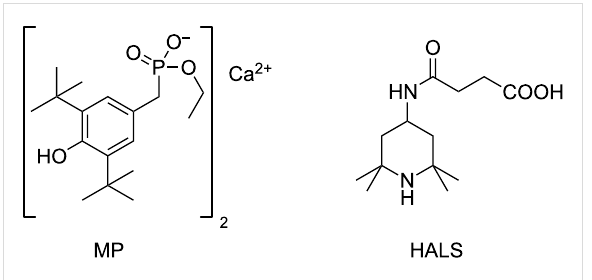
Figure 1: Molecular structures of Irganox 1425 (MP-Ca) and hindered amine light stabilizer (HALS).